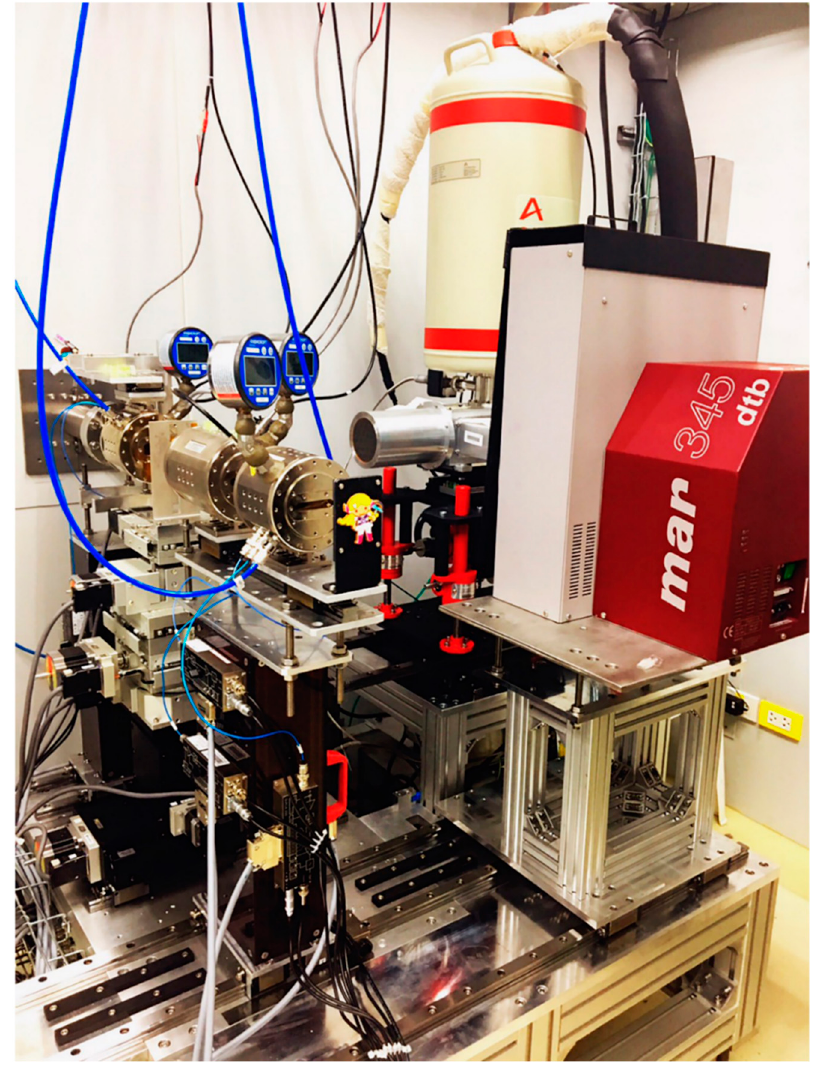
Figure 7 . Beamline 1.1W: Multiple X-ray Technique station (photo by C. Saiyasombat). Figure 7. Beamline 1.1W: Multiple X-ray Technique station (photo by C.